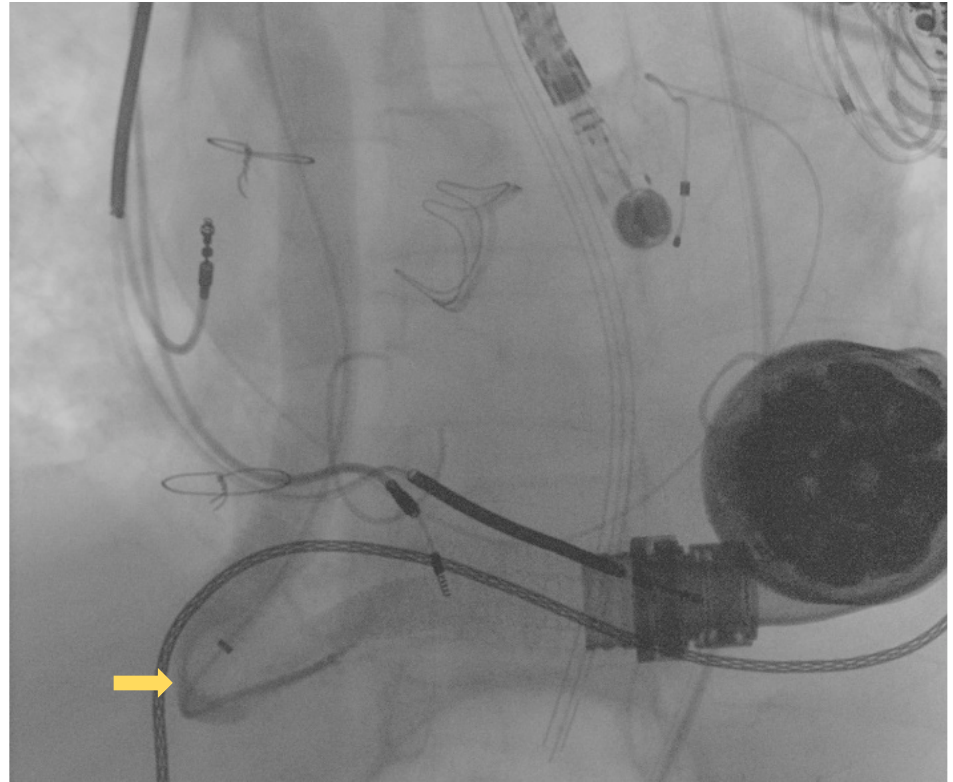
Figure 2. Diagnostic angiography showing recurrent outflow graft obstruction (yellow arrow).